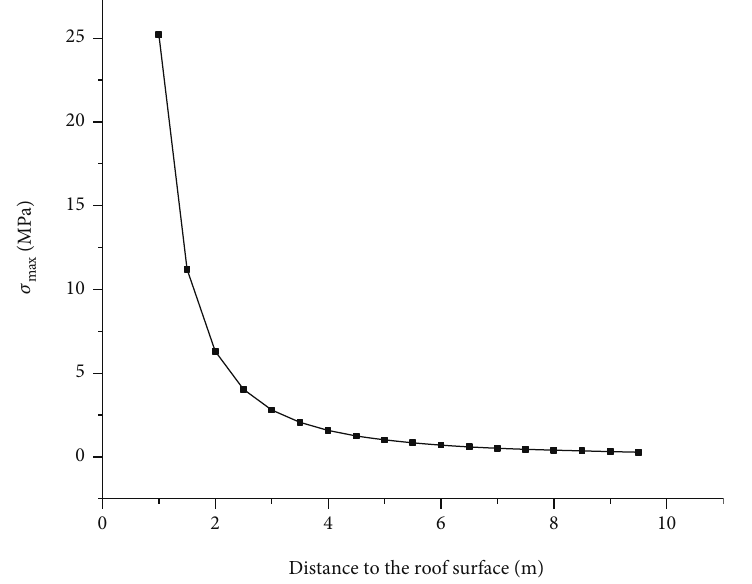
Figure 5: Tensile stress curve at di ff erent positions.